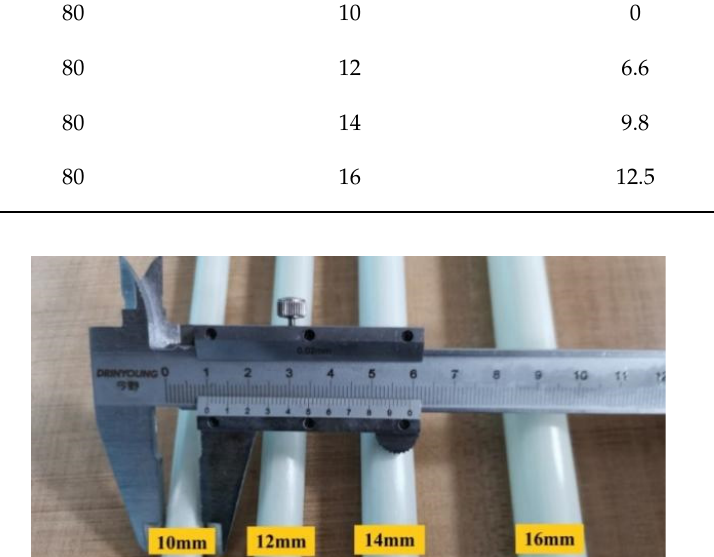
Table 4. Shear test specimen parameters.